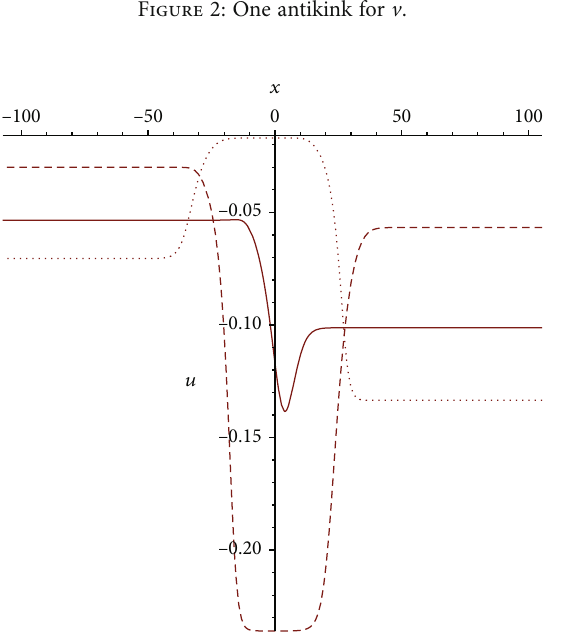
Figure 2: One antikink for v .